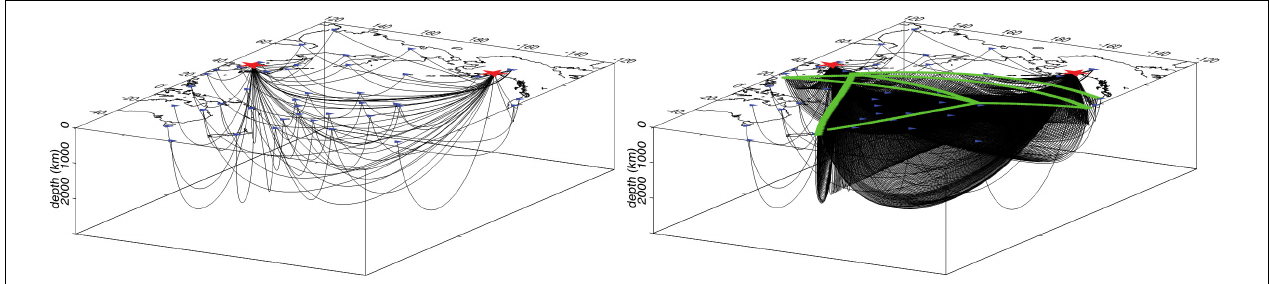
FIGURE 13 | Seismic ray coverage for two hypothetical sources in a block of the Pacific region. Coastlines are shown on the top. Sources are indicated as red stars in Cook Inlet, Alaska, and Korea. Rays, traced through the SALSA3D global P-wave model (Begnaud et al., 2011; Ballard et al., 2016) appear as curved lines from sources to receivers. Left: sampling of the Earth using today’s GSN (blue circles). Right: greater sampling afforded by addition of notional SMART cables, with 75-km sensor spacing (green circles; Ranasinghe et al., 2018). Permission obtained for use of